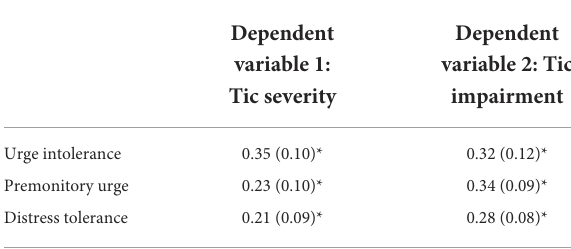
TABLE 2 Standardized path coefficients for bifactor model of urge intolerance, with premonitory urge and distress tolerance subfactors, predicting YGTSS tic severity and tic